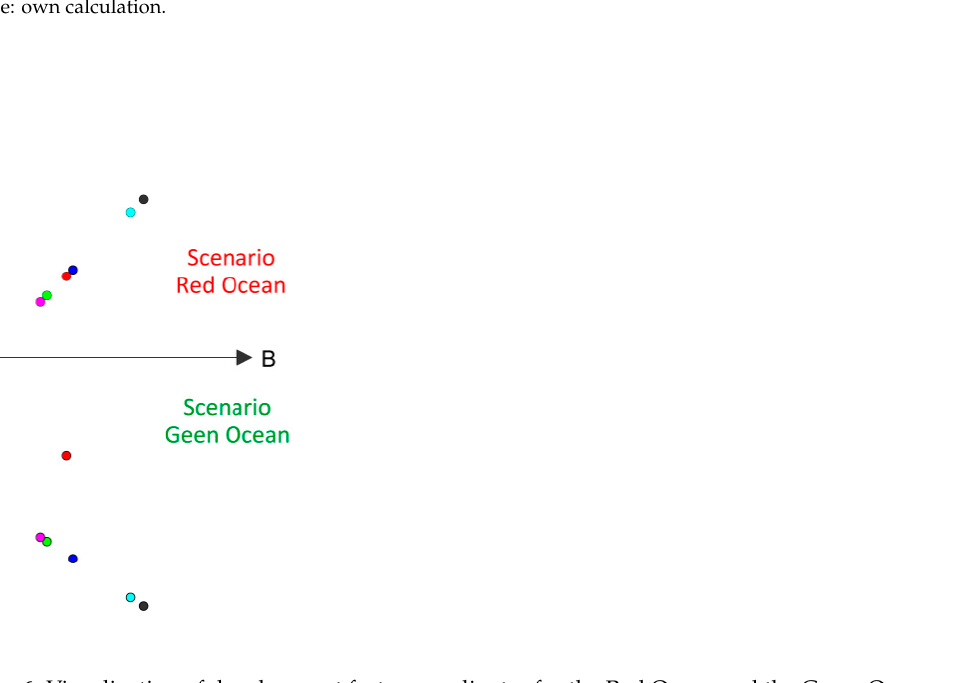
Figure 6. Visualization of development factor coordinates for the Red Ocean and the Green Ocean. Source: own calculation. The designations O, E, B and C are as shown in Figure 3.